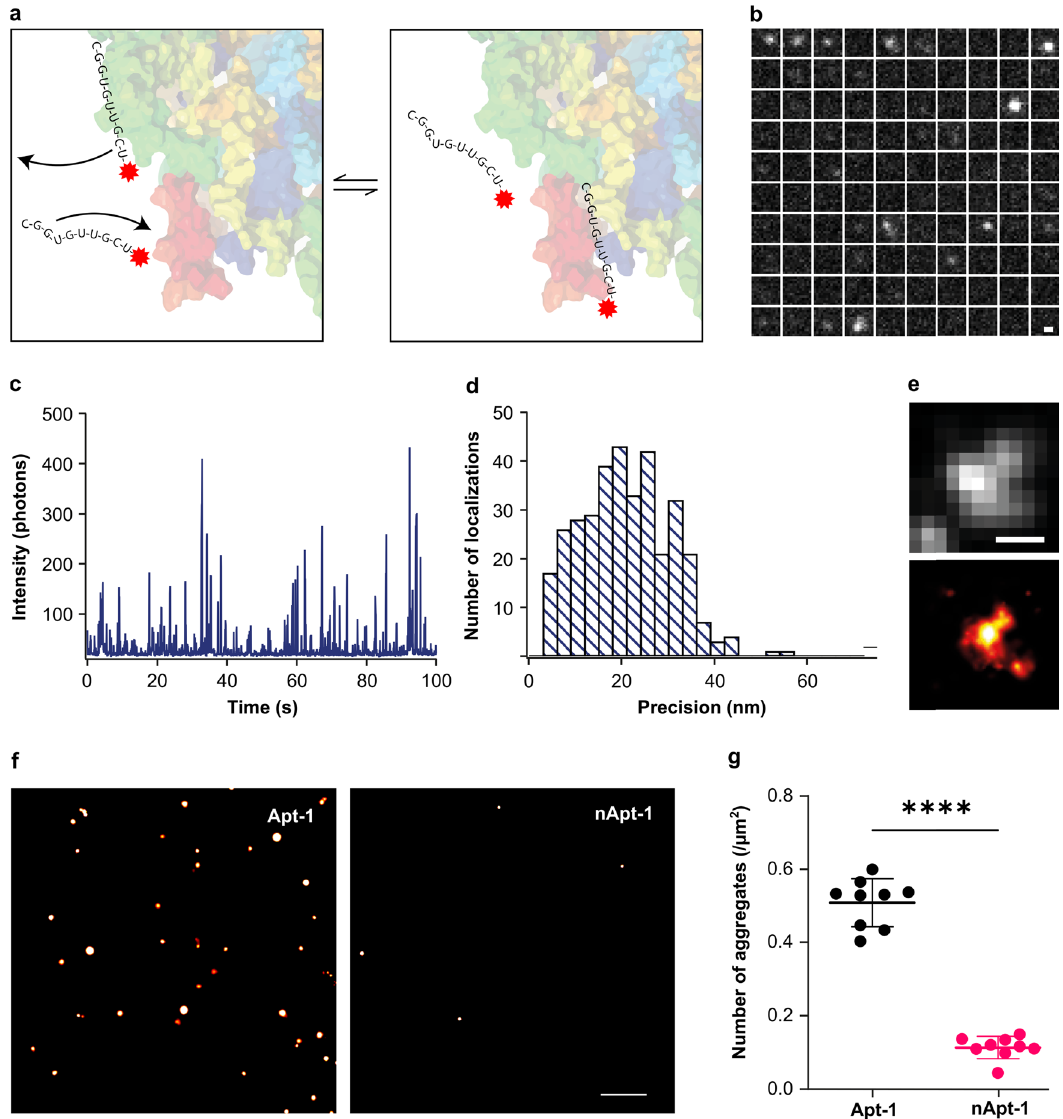
Fig. 4 SR imaging of surface-immobilized RRM1-2 aggregates. a Schematic representation of SR imaging. The immobilized RRM1-2 aggregate is transiently bound by an Atto590-tagged Apt1 molecule, the position of which is determined with nanometer precision. This process is repeated to generate a SR image of each aggregate. b Example time montage of an oligomer being imaged using PAINT. Each sub-image is separated by 1 s, moving through time from left to right then top to bottom; scale bar: 400 nm. c Intensity pro fi le of the oligomer imaged in ( b ). Individual localizations appear as bursts in intensity that are separated in space and time. d Histogram of precisions of the oligomer imaged in ( b ). Each localization is accurate positioned with a precision of 60 nm or less. e SR image (red hot) and diffraction-limited (gray) images of the aggregate shown in ( b ), scale bar is 500 nm. f Sample fi elds of view of clustered RRM1-2 aggregates imaged with Apt-1 and nApt-1, scale bar 1 μ m. Data from 3 independent experiments. g Compared to Apt-1 nAPt-1 detects signi fi cantly less RRM1-2 aggregates. The data shown are mean ± SD of 9 fi elds of view. **** p = 1.9769 × 10 − 11 ; analyzed by two-sided t -test, con fi dence interval 95%. Source data are provided as a Source data fi le 64